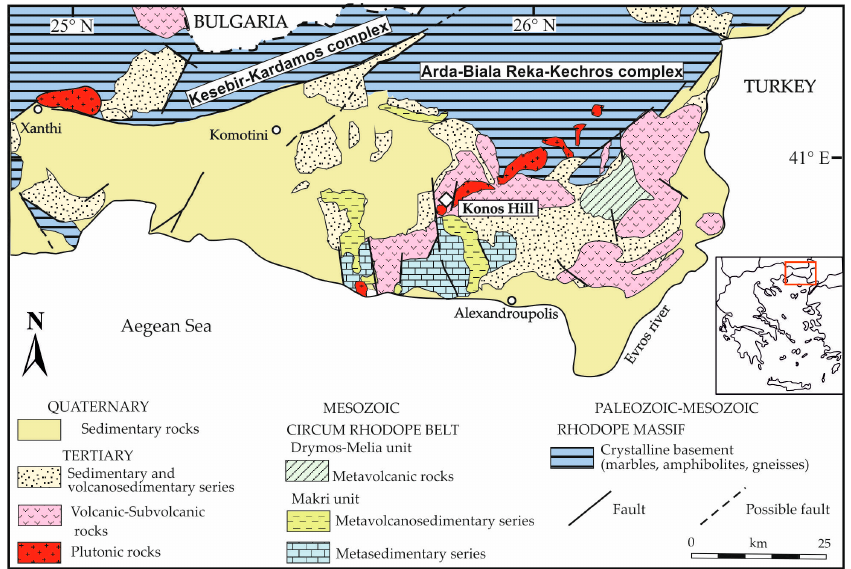
Figure 1. Geological map of NE Greece (modified from [22]). The white diamond marks the location of the study